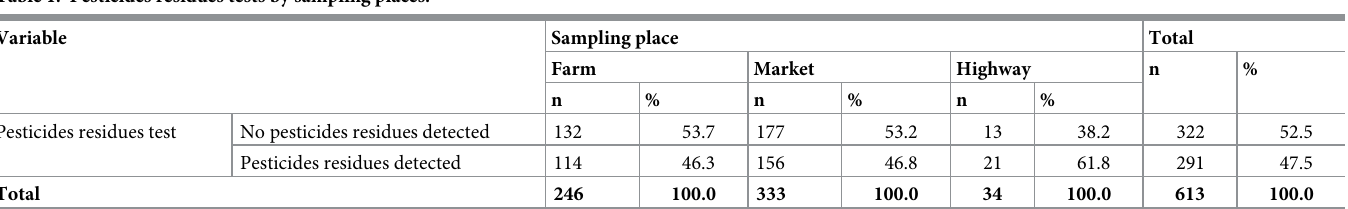
Table 1. Pesticides residues tests by sampling places.